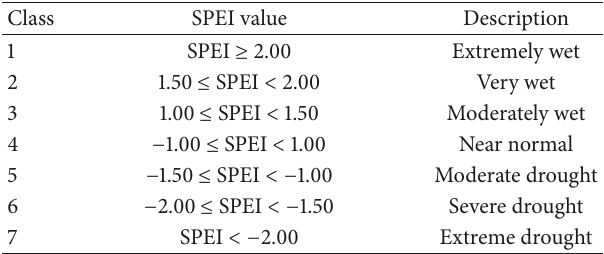
Table 1: Classification of SPEI